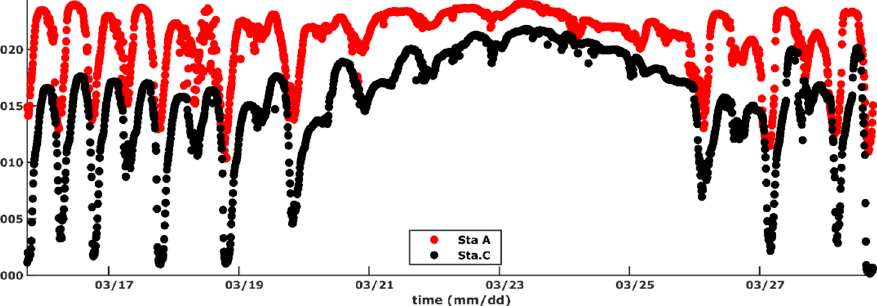
Figure 3. Tidal ranges ( left ) and subtidal elevations ( right ) at Stations A, B, and C.